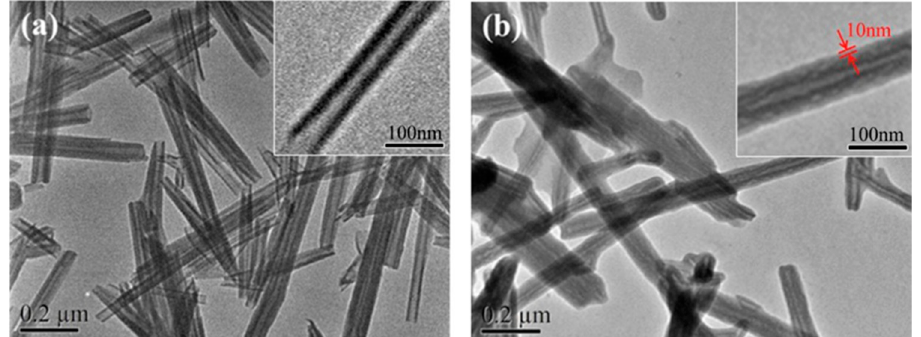
Figure 2. TEM images of ( a ) halloysite nanotubes and ( b ) quaternized halloysite nanotubes. Reproduced with permission from Ref. [23].